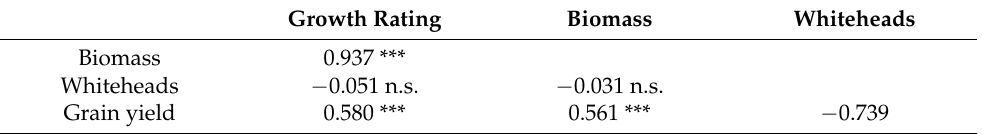
Figure 15. Response of wheat, durum (D,) and barley (B) cultivars to soil fumigation with methyl bromide, ( a ) whiteheads √ (arcsine %), and ( b ) grain yield. Graph ( a ) is presented in descending order and graph ( b ) in ascending order, respectively of values for nil-treated cultivars. Bar markers represent the l.s.d. ( a ) main effect of cultivar, and ( b ) main effects of fumigation and cultivar from ANOVA. Values above bars are percentage response to fumigation. Table 7. Correlation matrix between measures of plant growth of all cultivars growing on either nil-treated or fumigated soil ( n =